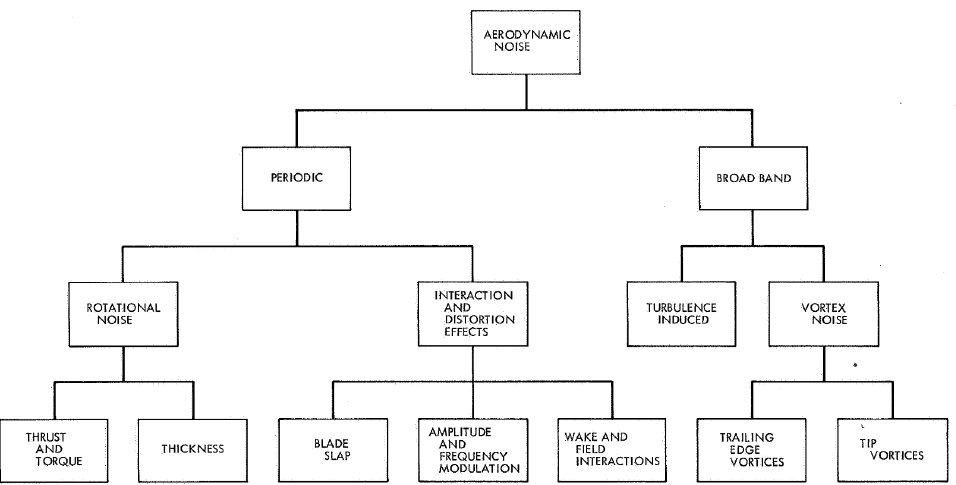
Figure 3. Summary and classification of acoustic sources in propellers [16]. Work of the US Gov. Public Use